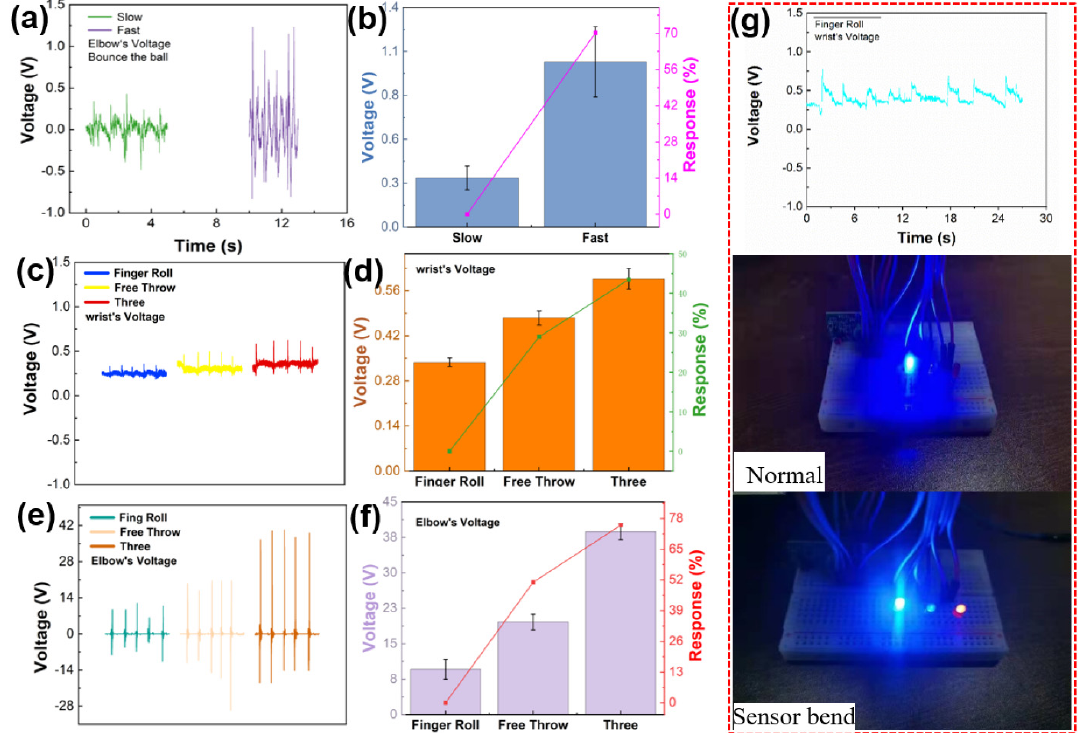
Figure 5. Practical application of the sensor. ( a ) Output piezoelectric voltage of ball bouncing. ( b ) Output piezoelectric voltage response of wrist joint during bouncing. ( c ) Output piezoelectric voltage of wrist joint during shooting. ( d ) Output piezoelectric voltage response of wrist joint during shooting. ( e ) Output piezoelectric voltage response of elbow joint during shooting. ( f ) Output piezoelectric voltage response of elbow joint during shooting. ( g ) Drive simple Bluetooth equipment.